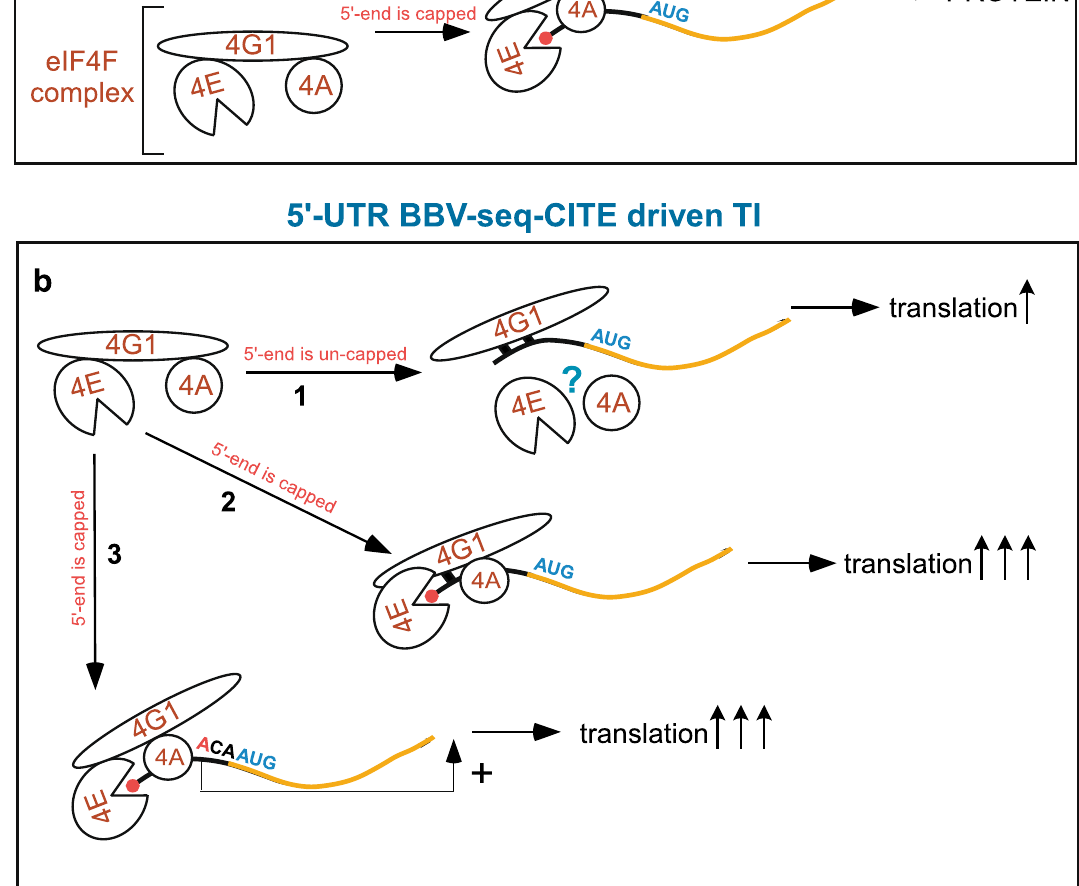
Figure 8. Models for conventional, cap-dependent, and proposed BBV-seq-CITE mediated translation initiation. ( a ) During conventional translation initiation (TI), the eIF4F complex (shown on the left) primes cap-modified mRNA (cap is shown as red circle). eIF4E binds to the m7G cap, while eIF4G1 acts as a scaffolding protein by placing the helicase eIF4A on the 5 ʹ -UTR (black line). eIF4F activity promotes efficient translation initiation, resulting in decoding of mRNA (orange line) and efficient protein synthesis ( ↑↑↑ )